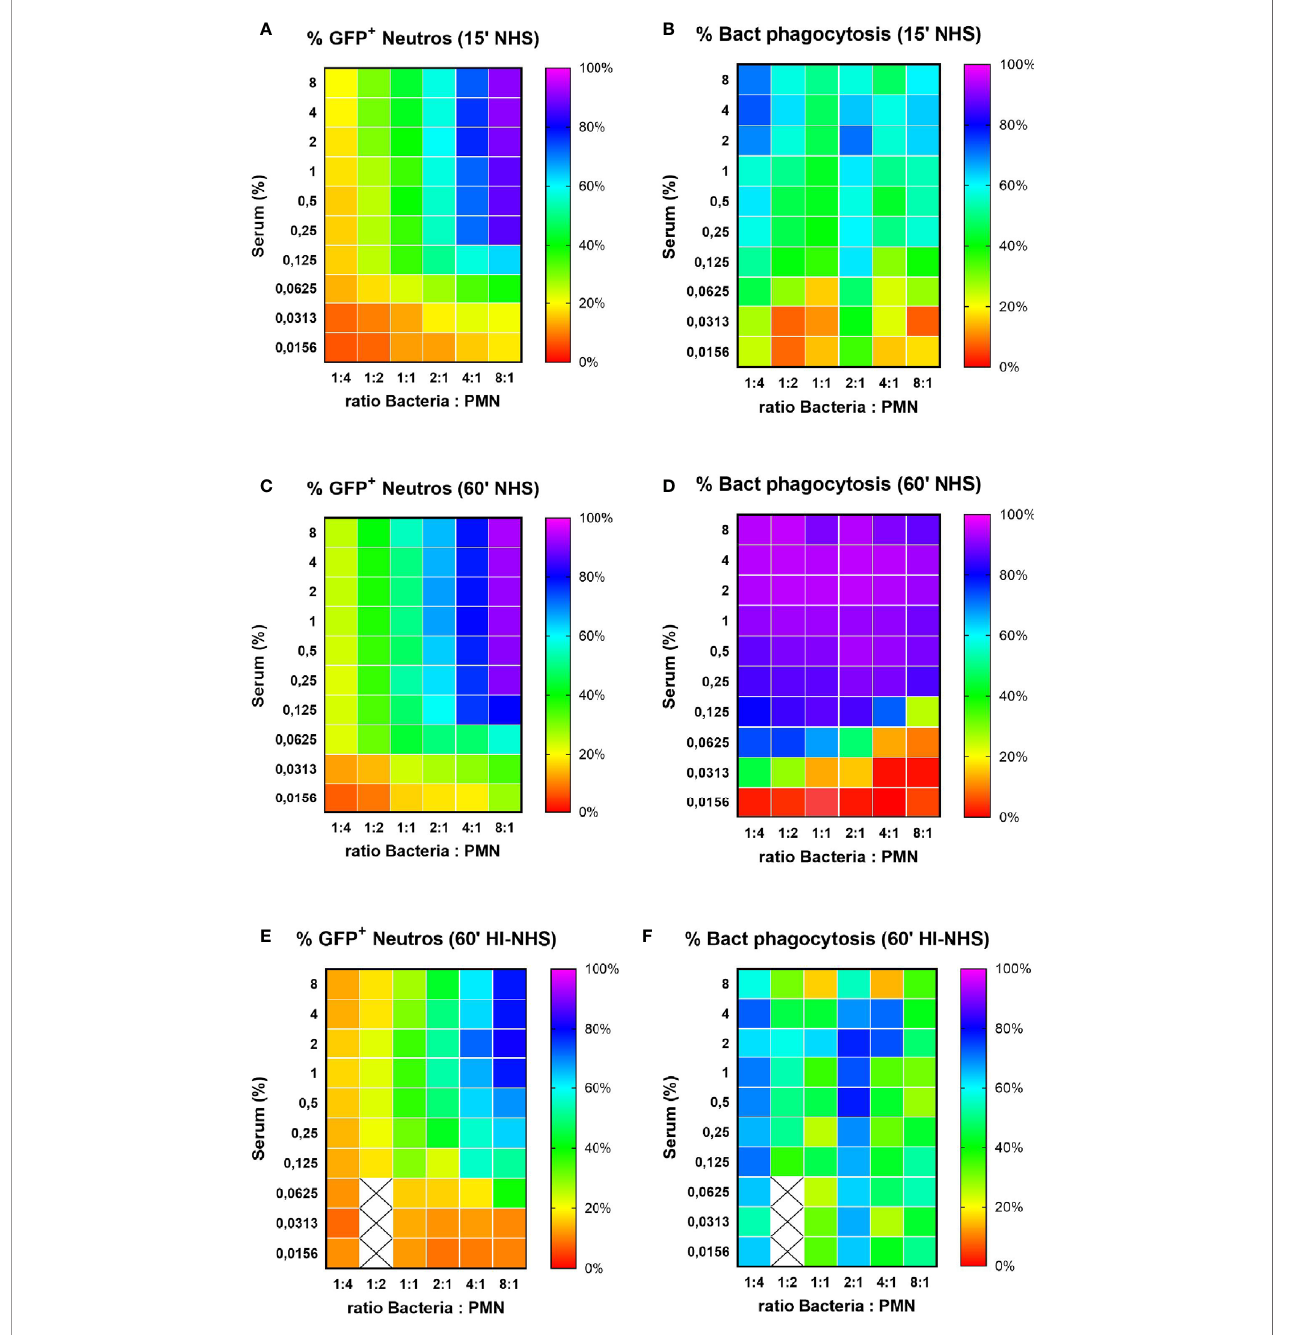
FIGURE 7 | Percentage of phagocytosing neutrophils vs. % phagocytosed bacteria. Heat map visualization of both % GFP+ neutrophils (left side panels) and % bacterial phagocytosis (right side panels) for increasing ratios of bacteria to neutrophils. Results for 15 (A, B) and 60 (C, D) min phagocytosis in the presence of increasing concentration NHS and for 60 min phagocytosis in the presence of HI-NHS (E, F) . Data are mean values of n=3 experiments, and X are missing data